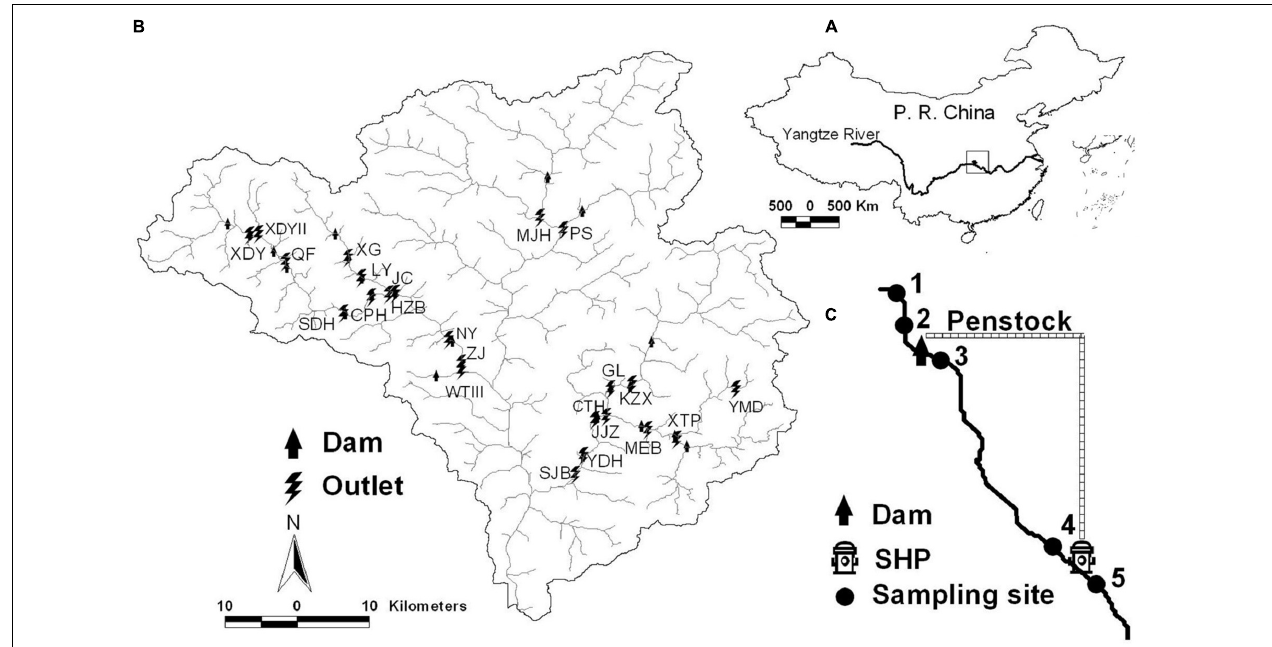
FIGURE 1 | Small run-of-river dams within the Xiangxi River watershed (B) in the People’s Republic (P. R.) of China (A) and sketch map of sampling sites (C) . SHP, small hydropower station; letters in (B) are names of SHPs. The figure was modified from Wang et al. (2022).